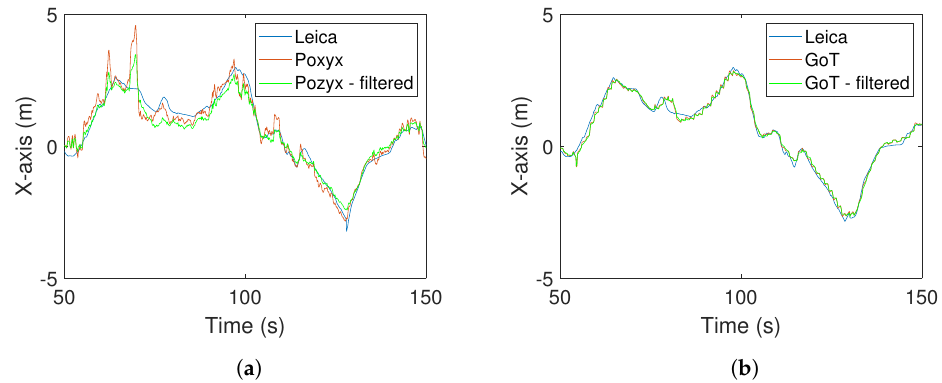
Figure 15. X-direction traces after pre-filtering with and without Wiener filtering. ( a ) Leica/Pozyx X-direction traces in time domain. ( b ) Leica/GoT X-direction traces in time